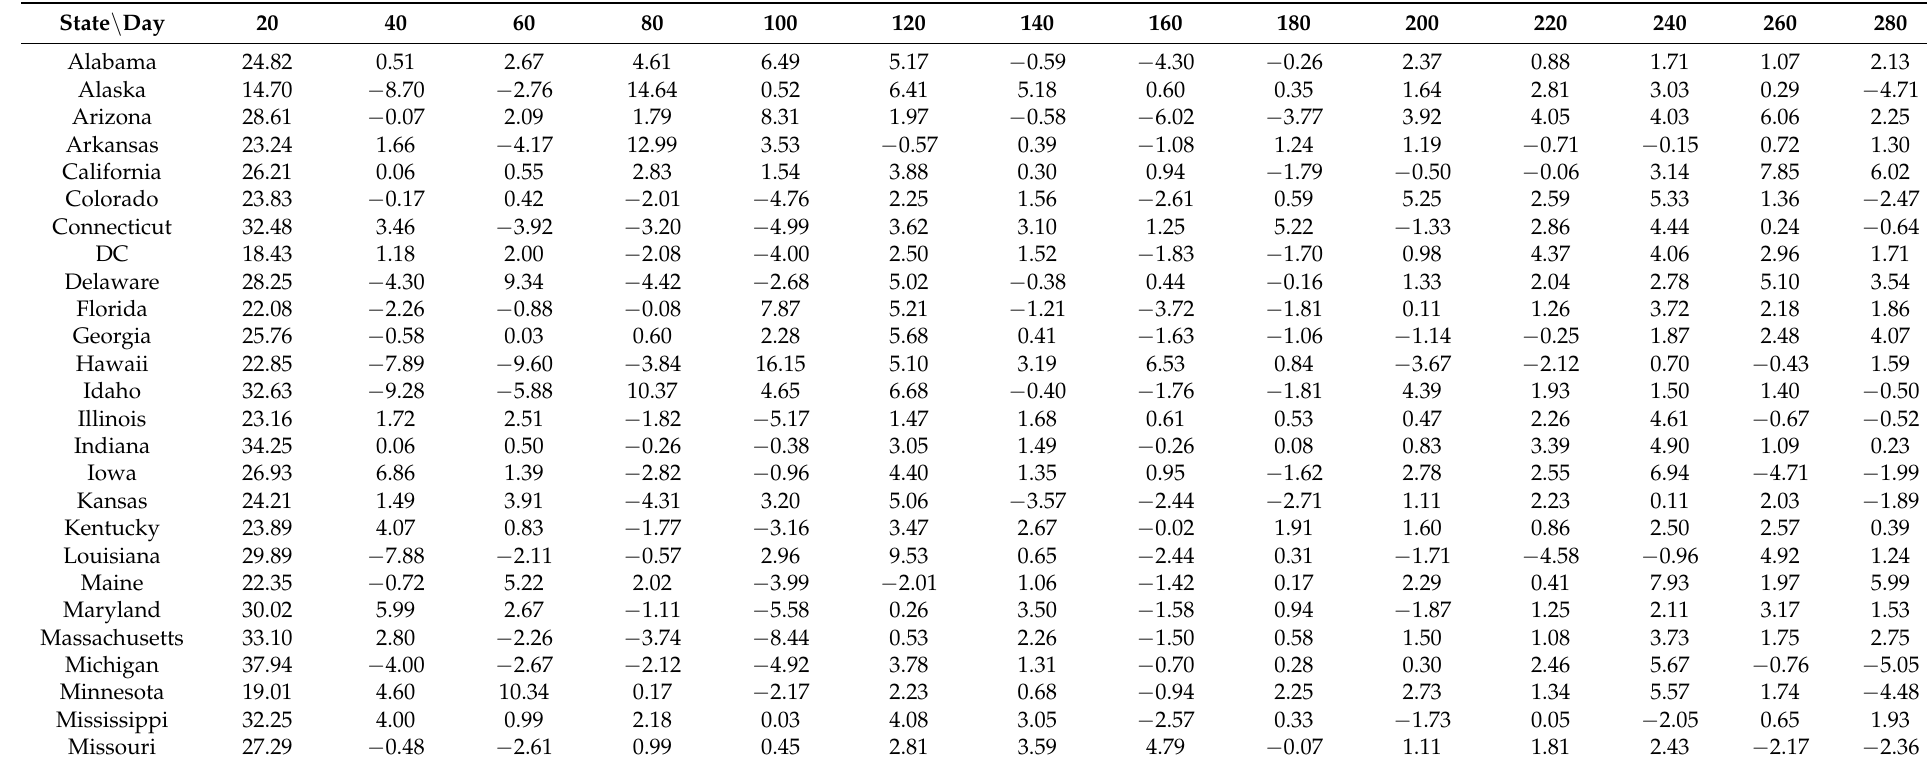
Table 3. Spread rates ( × 100) for COVID-19 in the 50 states of the USA and the district of Columbia for 14 consecutive nonoverlapping 20-day time periods. N > 0 are numbers of positive rates, Mean indicates mean rates. Days are since pandemic onset in that state, which differs among states. P K-S are p -values along the Kolmogorov–Smirnov test for